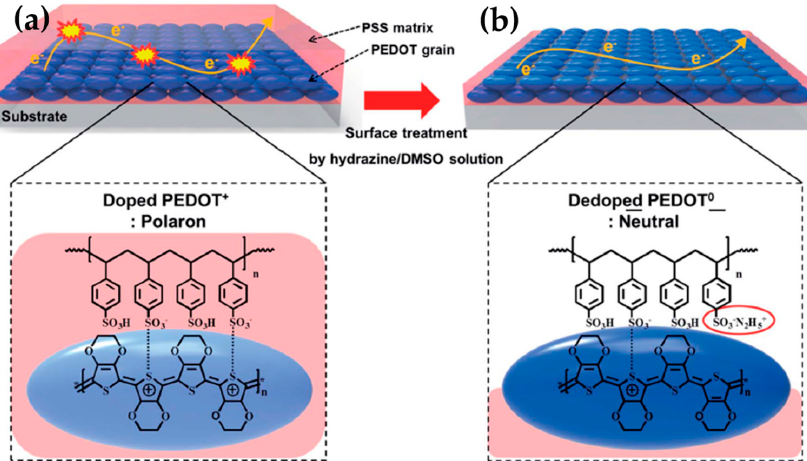
Figure 3. An overall scheme for the spin-coated PEDOT:poly(styrenesulfonate) (PSS) film fabricated by the sequential treatment of p-toluenesulfonic acid monohydrate (TSA)/dimethyl sulfoxide (DMSO) doping and hydrazine/DMSO dedoping. ( a ) DMSO/TSA-doped PEDOT:PSS film formation via spin coating and selective removal of PSS and the dedoped PEDOT:PSS (DDTP) film treated with hydrazine/DMSO solution ( b ). Reprinted with permission from [32]. Copyright 2014 The Royal Society of Chemistry.